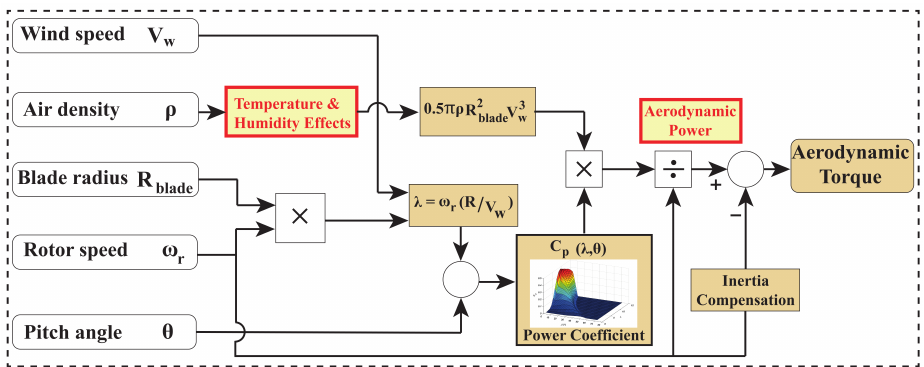
Figure 1. Block diagram of WT modeling with temperature and humidity